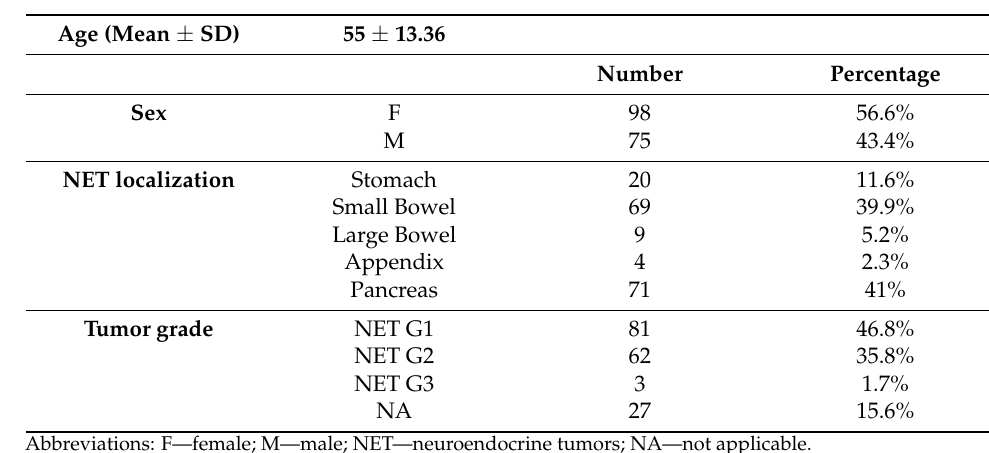
Table 1. Patients’ characteristics.